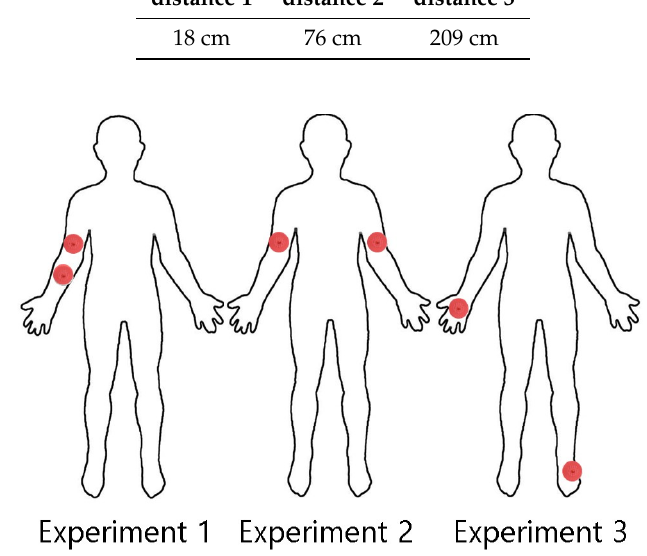
Figure 2. Three different experiment settings for testing the EM wave signal